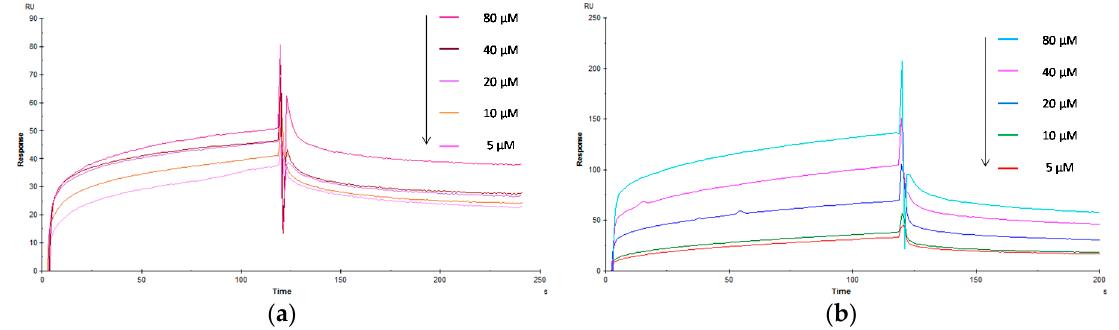
Figure 3. Sensorgram obtained for the binding interactions of Con A with glycopolymers. ( a ) Compound 8a ; ( b ) Compound 8b . Spike-like signals (inflections) might have been due to the bulk effect [28,29].